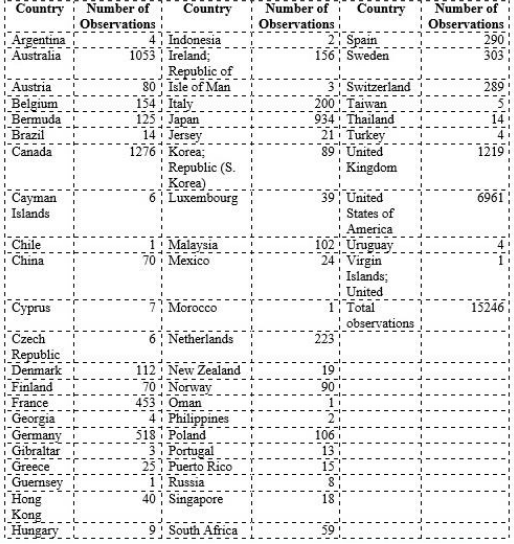
Table 1c: Number of Observations by Country